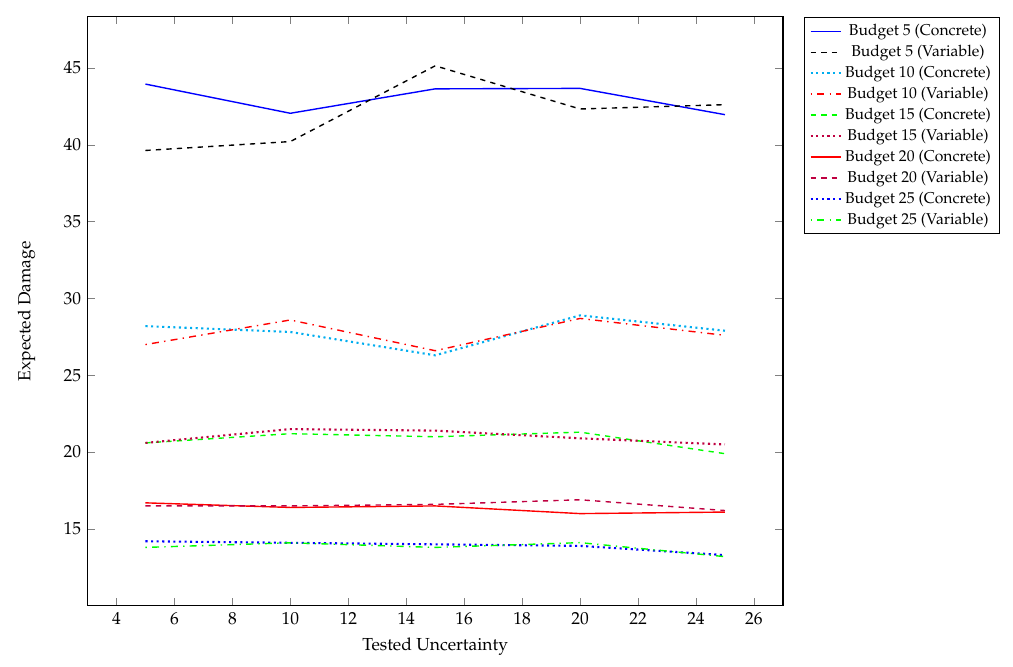
Figure 2. Expected damage tracked against uncertainty for each experimental